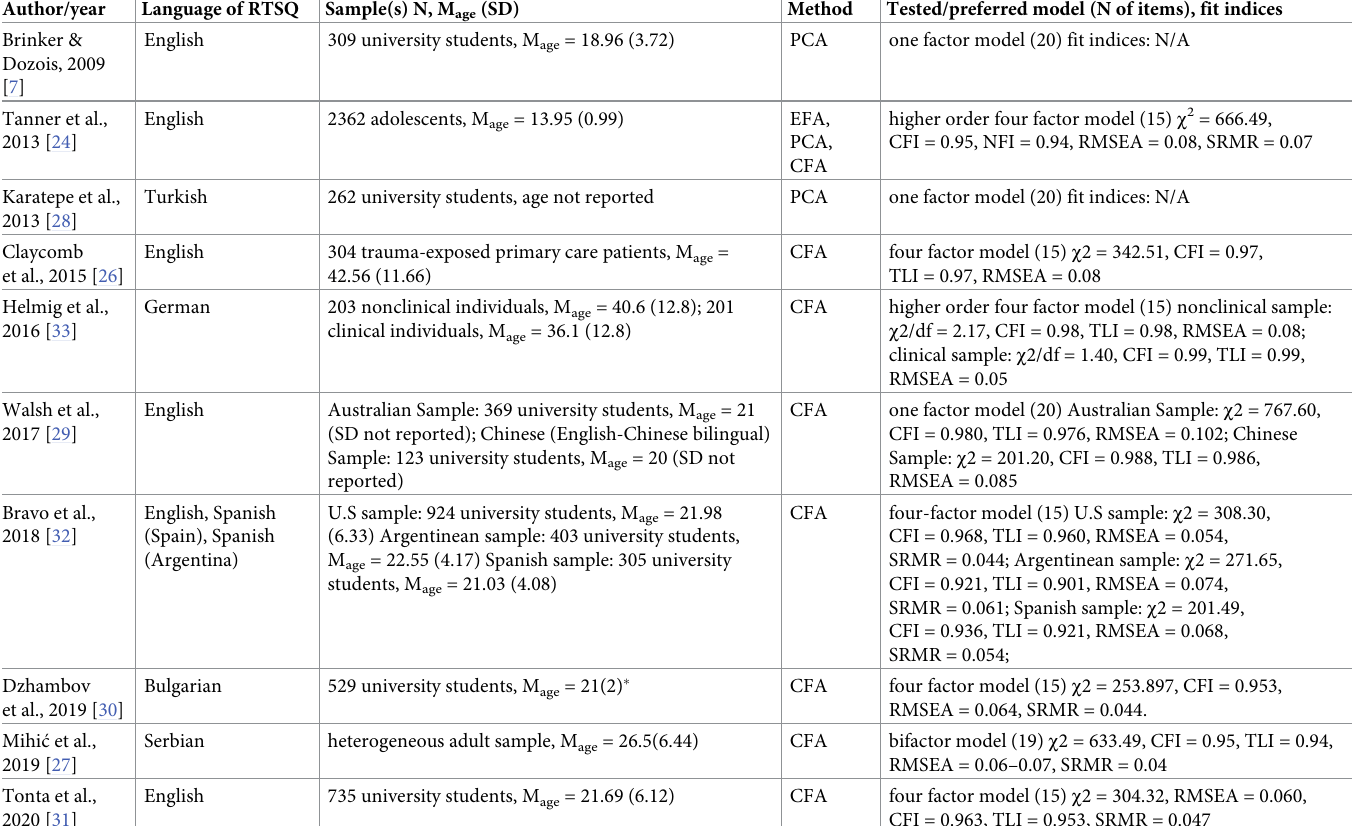
Table 1. Empirical studies assessing the factor structure of the RTSQ in different cultural and linguistic